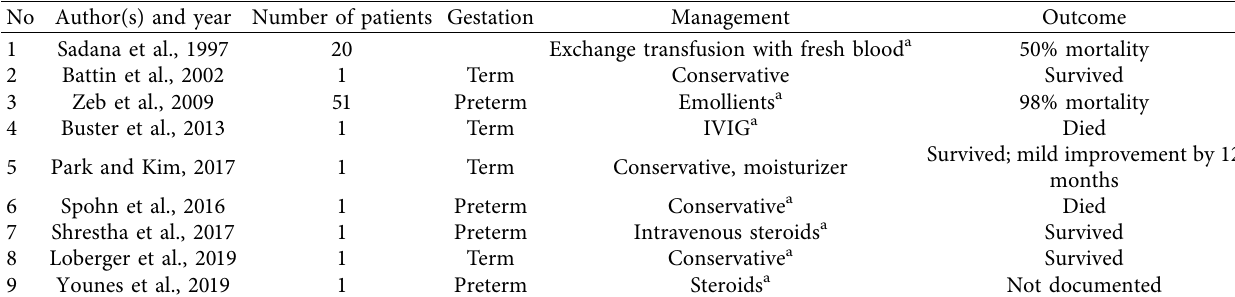
Figure 2: Histology findings of skin biopsy showing extensive fibrosis with dense subepithelial collagen deposition, sparse inflammatory cell infiltration (black arrow), and entrapment of the dermal adnexa between the collagen fibers (white arrow) (a, b). Atrophy of the epidermis and loss of epidermal papilla (c) (H&E stain × 10). Table 1: Treatment and outcomes of sclerema neonatorum over the last 25